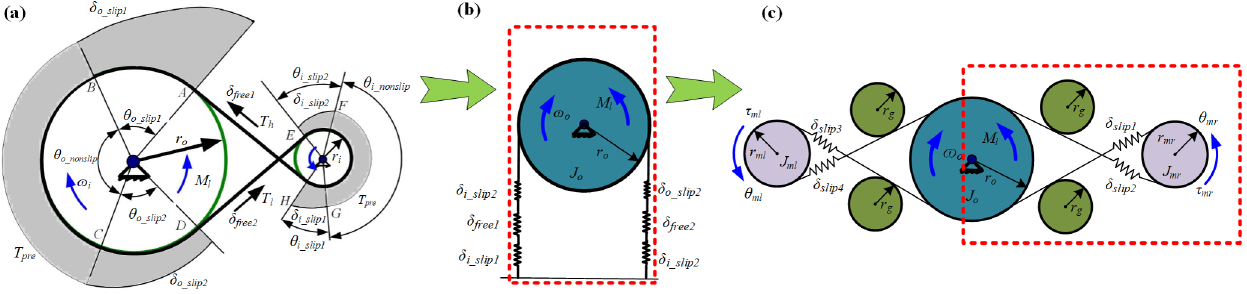
Figure 3. Development of transmission backlash model of proposed configuration: (a) tension profile and Affected angles of wrap; (b) equiv- alent model of SISO configuration; (c) equivalent model of proposed